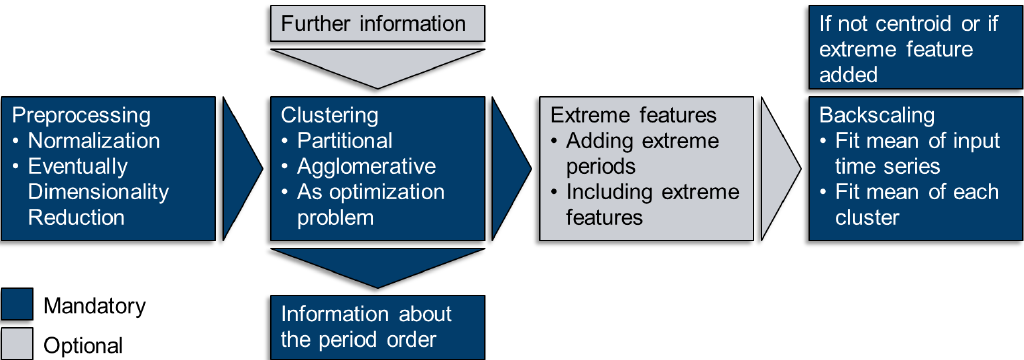
Figure 9. Steps for clustering time series for energy system models (ESMs).